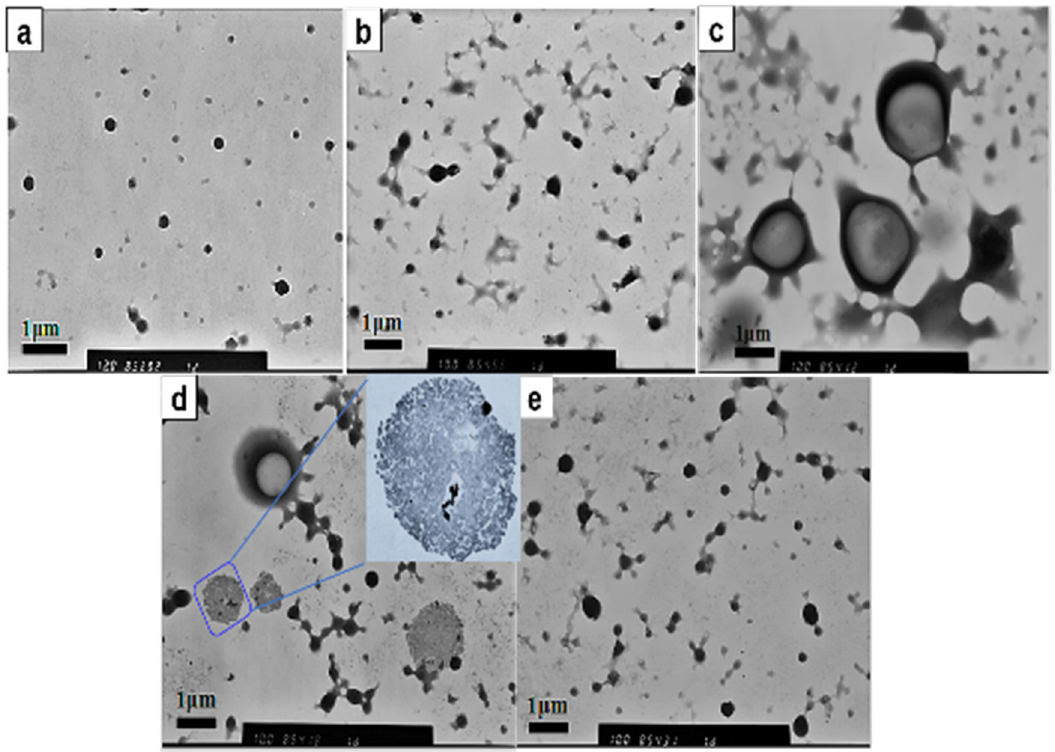
Figure 4: TEM images of aggregates formed from DSPE – PEG2k and PDLLA – MPEG micelle ( at a mass ratio of 0.02:1 ) mixed solutions at di ff erent mixing time: ( a ) 0 h, ( b ) 1 h, ( c ) 6 h, ( d ) 12 h and ( e ) 24